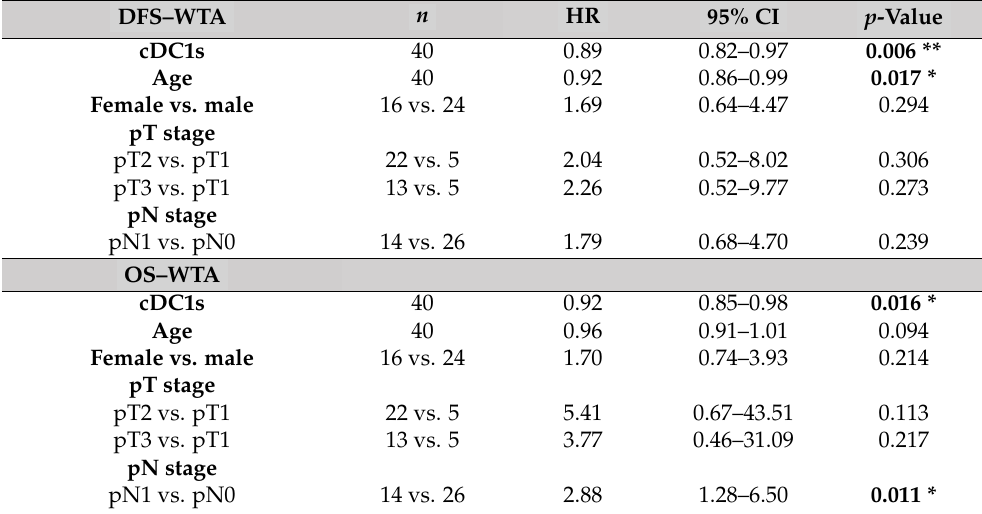
Table 2. Higher densities of whole tumor area (WTA)-infiltrating conventional dendritic cells type 1 (cDC1s) are associated with favorable disease-free survival (DFS) and overall survival (OS). Hazard ratios (HR) and 95% confidence intervals (CI) are shown.